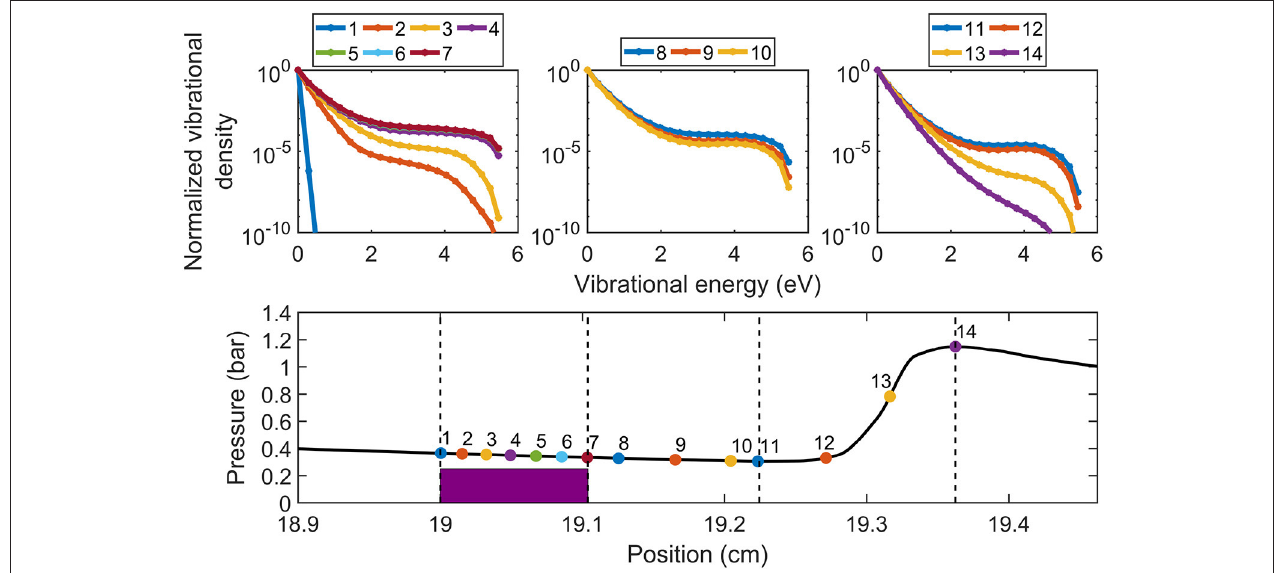
FIGURE 10 | Calculated evolution of the VDF in a MW plasma with Laval nozzle for supersonic expansion, for different axial positions, as indicated in the lower panel, showing the pressure evolution as a function of position in the supersonic expansion region and shock wave, for an SEI of 0.2 eV/molec, an inlet and outlet pressure of 2 and 1 bar, respectively. Adopted from Vermeiren and Bogaerts (2018) with